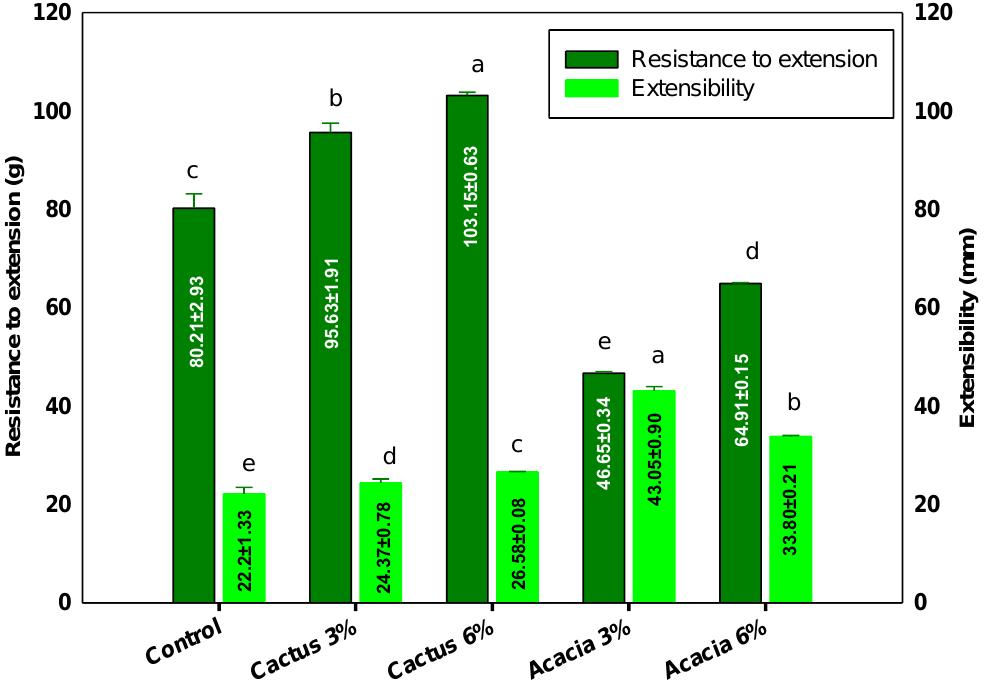
Figure 1. Dough extensibility properties of flour gum blends. Values followed by different letters same color bars are significantly different at p < in same color bars are significantly different at p < 0.05.